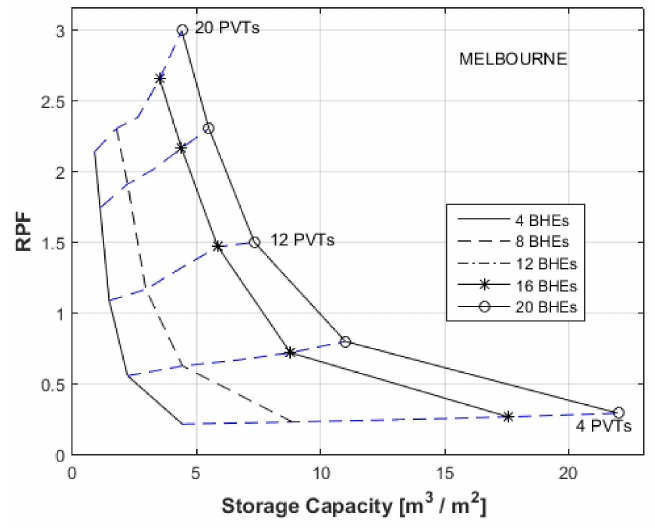
Figure 5. RPF for Melbourne as function of the storage